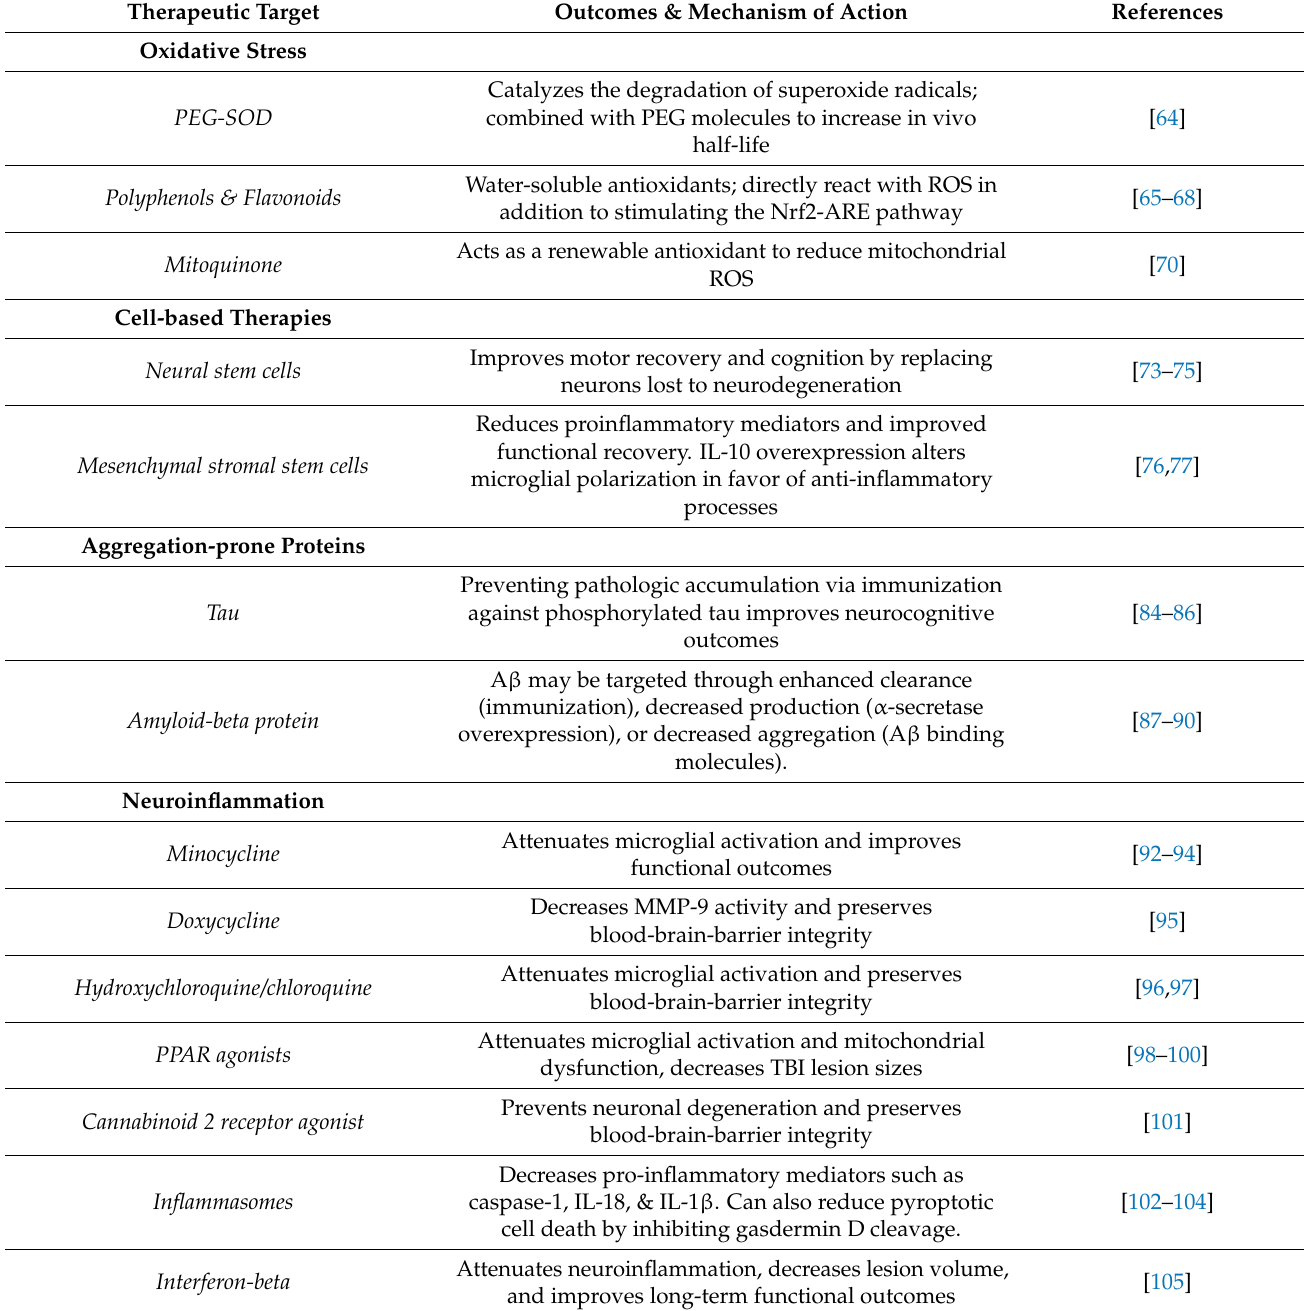
Table 2. Preclinical Studies of Secondary Neurodegeneration